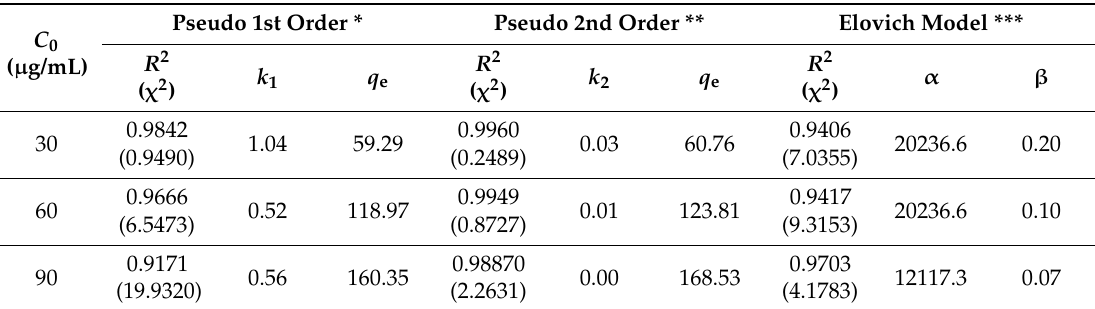
Table 3. Kinetic parameters estimated from pseudo 1st order, pseudo 2nd order, and Elovich models and evaluation of the respective fittings for initial paraquat concentrations ( C 0 ): 30, 60 and 90 µ g/mL.